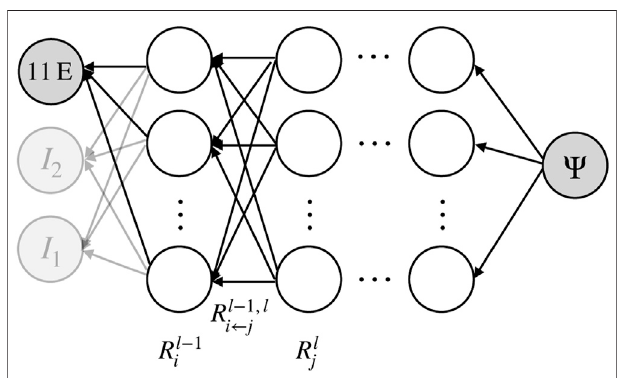
FIGURE 4 | Illustration of layer-wise (backwards) relevance propagation in a CANN. In a trained neural network, recursive application of this scheme from the output layer to the input layer can quantify the relevance of the individual input parameters such as the ELISA values for the output. Neurons are illustrated as empty circles, weights as black